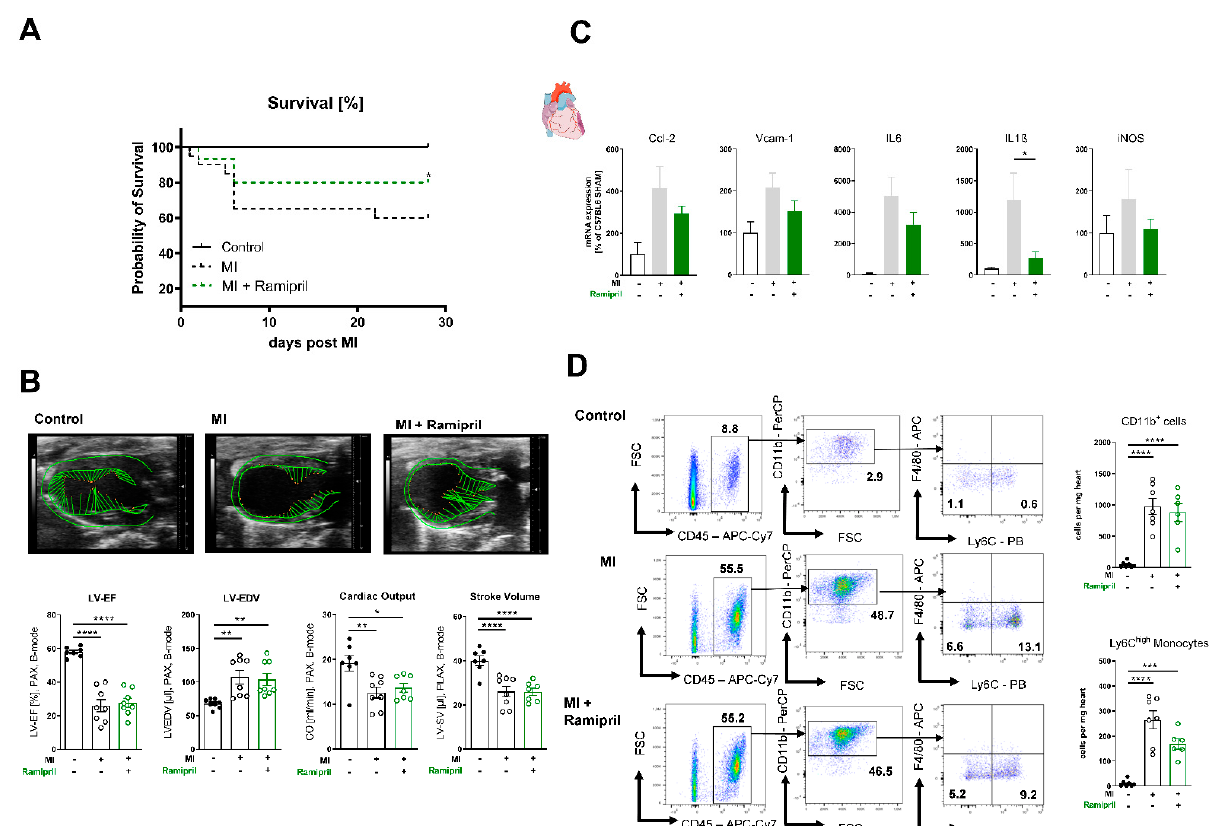
Figure 1. Early ramipril treatment limits infiltration of inflammatory monocytes to the ischemic myocardium and expression of adhesion molecules after MI(myocardial infarction). ( A ) Kaplan–Meier survival curve after MI or MI mice with ramipril treatment vs. sham-treated (control) over the period of 28 days. n = 12–26 per group; Log-Rank (Mantel–Cox test). ( B ) Transthoracic echocardiography measured in parasternal long axis (PLAX) with analysis of left ventricular ejection fraction (LV-EF), left ventricular end-diastolic diameter (LV-EDV), cardiac output and stroke volume on day 6 after MI vs. sham, (top) representative PLAX B-mode images, (bottom) quantification; n = 7–8 per group; ( C ) mRNA expression of heart tissue of Ccl-2, Vcam-1, Il6, Il1b and iNOS (Nos2) 7 days after MI and sham operation; n = 6–7 mice per group; ( D ) Left: Representative gating strategies of CD45 + CD3 − CD11b + and CD45 + CD3 − CD11b + Ly6G − Ly6C high . Bold numbers indicate the percentual ratio of total living cells. Right: Flow cytometry quantification of infiltrating CD11b + myeloid cells and Ly6C high monocytes in the infarcted heart vs. sham operation 7 days after MI, n = 6–7 mice per group; mean + SEM, 1-way ANOVA or Kruskal–Wallis test with Dunn’s multiple comparisons test, * p < 0.05, ** p < 0.01 , **** p < 0.0001.